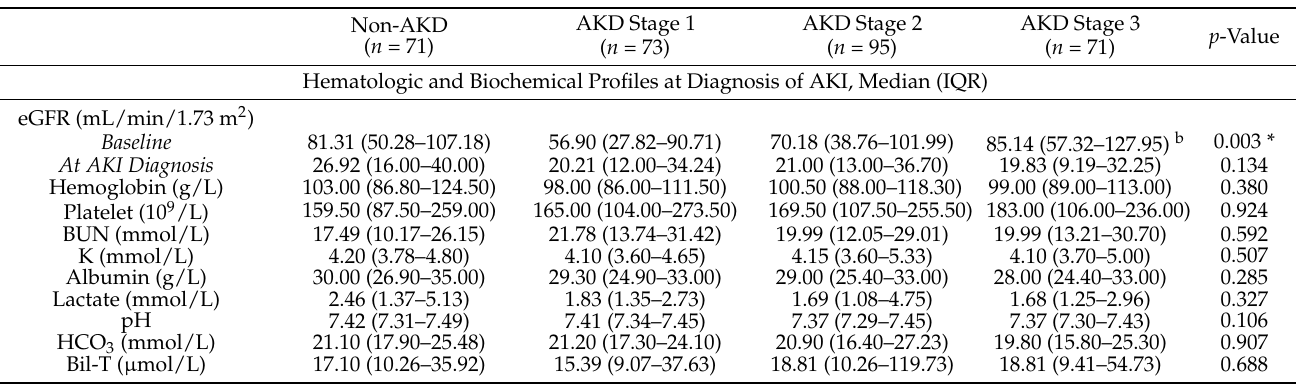
Table 3. Hematologic and biochemical profiles associated with AKD Severity in patients with AKI.